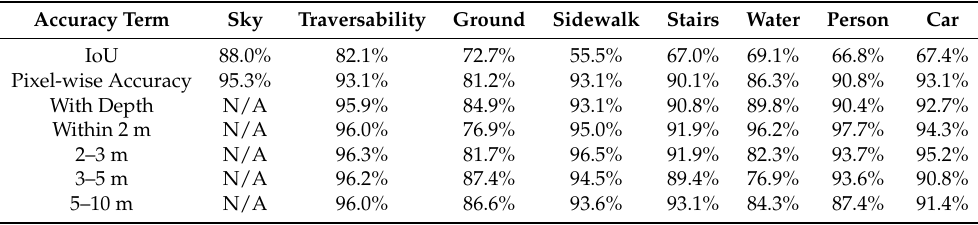
Table 5. ERF-PSPNet on the real-world dataset [71] in terms of terrain awareness. “Traversability”: Accuracy of the traversable area parsing. Depth information of sky is too sparse to calculate reasonable accuracy values at different